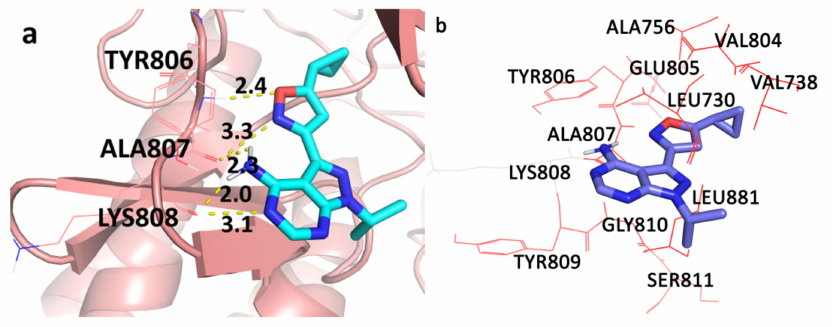
Figure 3. ( a ) 100 ns MD conformation of the most active compound 25 (shown in cyan color and stick model) inside the active site of RET kinase. Hydrogen bonds are represented as yellow dotted lines and their distances are labeled in angstrom. ( b ) The most active compound 25 (shown in stick model) inside the hydrophobic pocket of RET; hydrophobic residues are shown in the red colored line